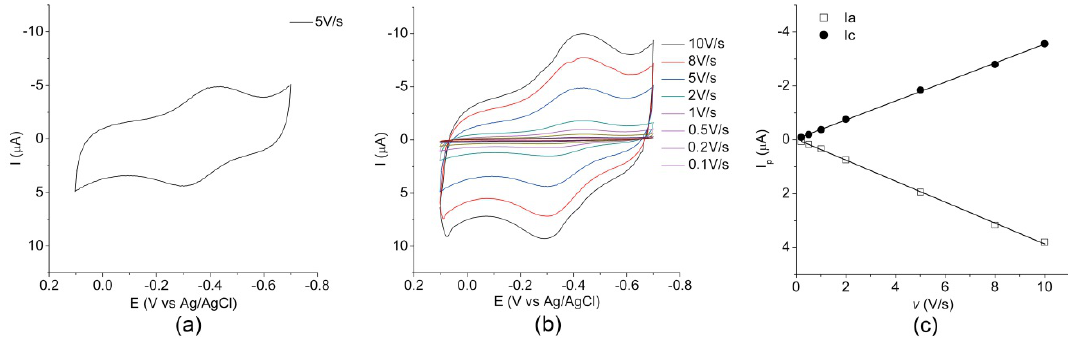
Figure 2. Electrochemical characterization of MIMO@LA. ( a ) Cyclic voltammograms for MIMO@LA on the gold electrode in 10.0 mM phosphate buffer solution, pH 7.0, at scan rate ( ν ) 5.0 V/s. Measurements are reported vs. Ag/AgCl electrode. ( b ) Cyclic voltammograms for MIMO@LA on the gold electrode in 10.0 mM phosphate buffer solution, pH 7.0, recorded in the scan range 0.1–10.0 V/s. ( c ) Peak current intensity dependence (I p ) versus v. I c and I a are the peak current intensities of the cathodic and anodic peaks, respectively.